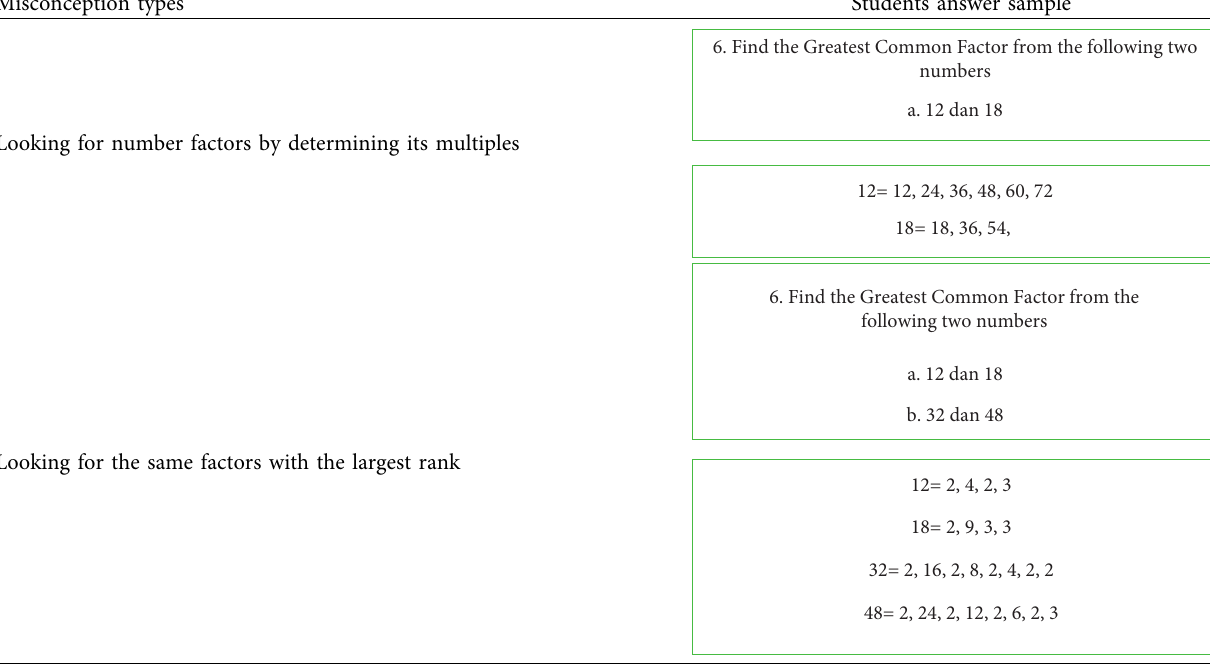
Table 13: Students misconception in question 6 and its answer